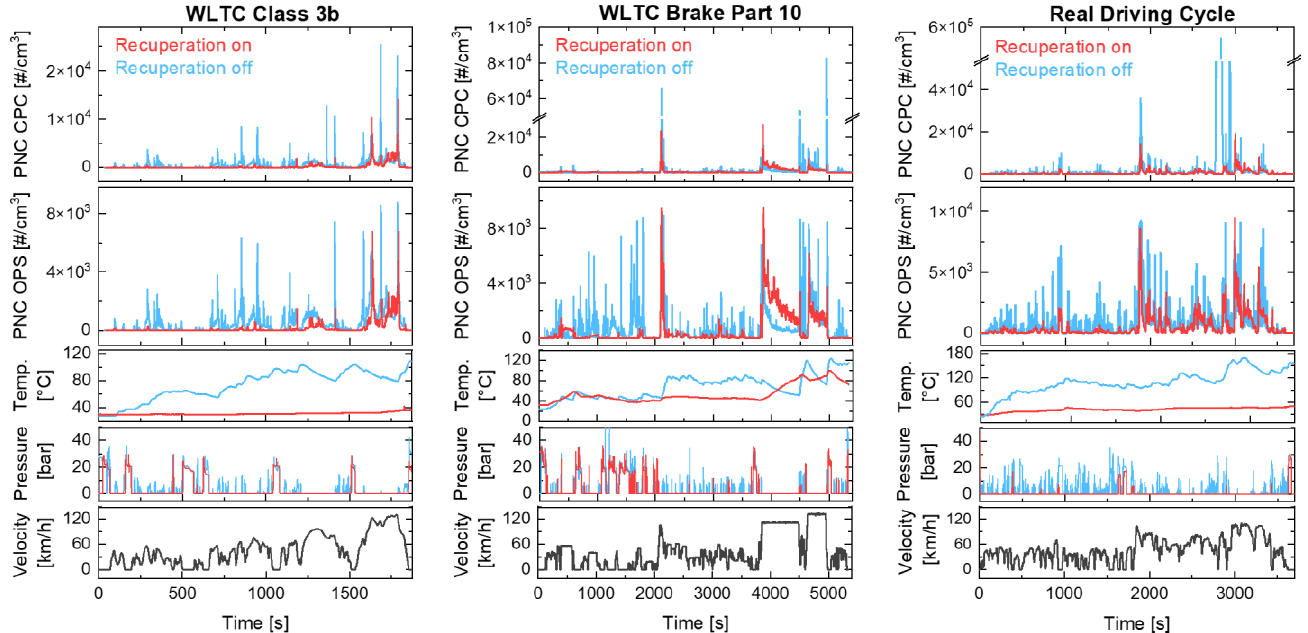
Figure 5. Comparison of airborne particle emissions for three driving cycles with and without recuperation. Ultrafine and fine particle number concentration from a CPC with a particle diameter between 4 nm and 3 μm, and coarse particles between 300 nm and 10 μm detected by an OPS. Vehicle and brake parameters included the velocity of the vehicle, pressure of the hydraulic brake, and brake temperature.